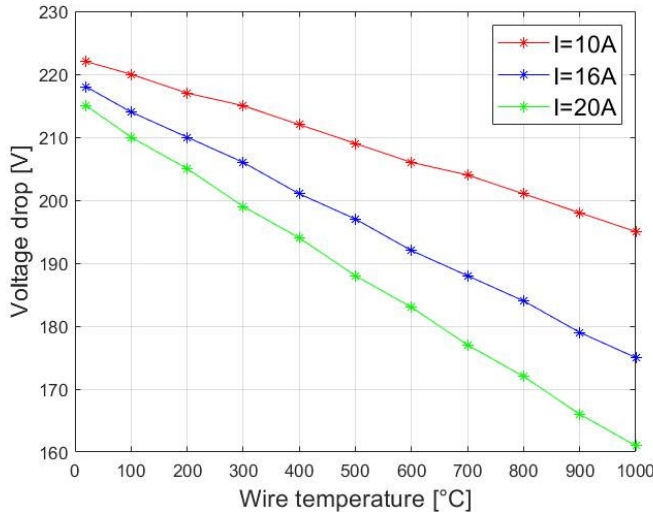
Figure 16. Simulated voltage drop for various current loads of cables.